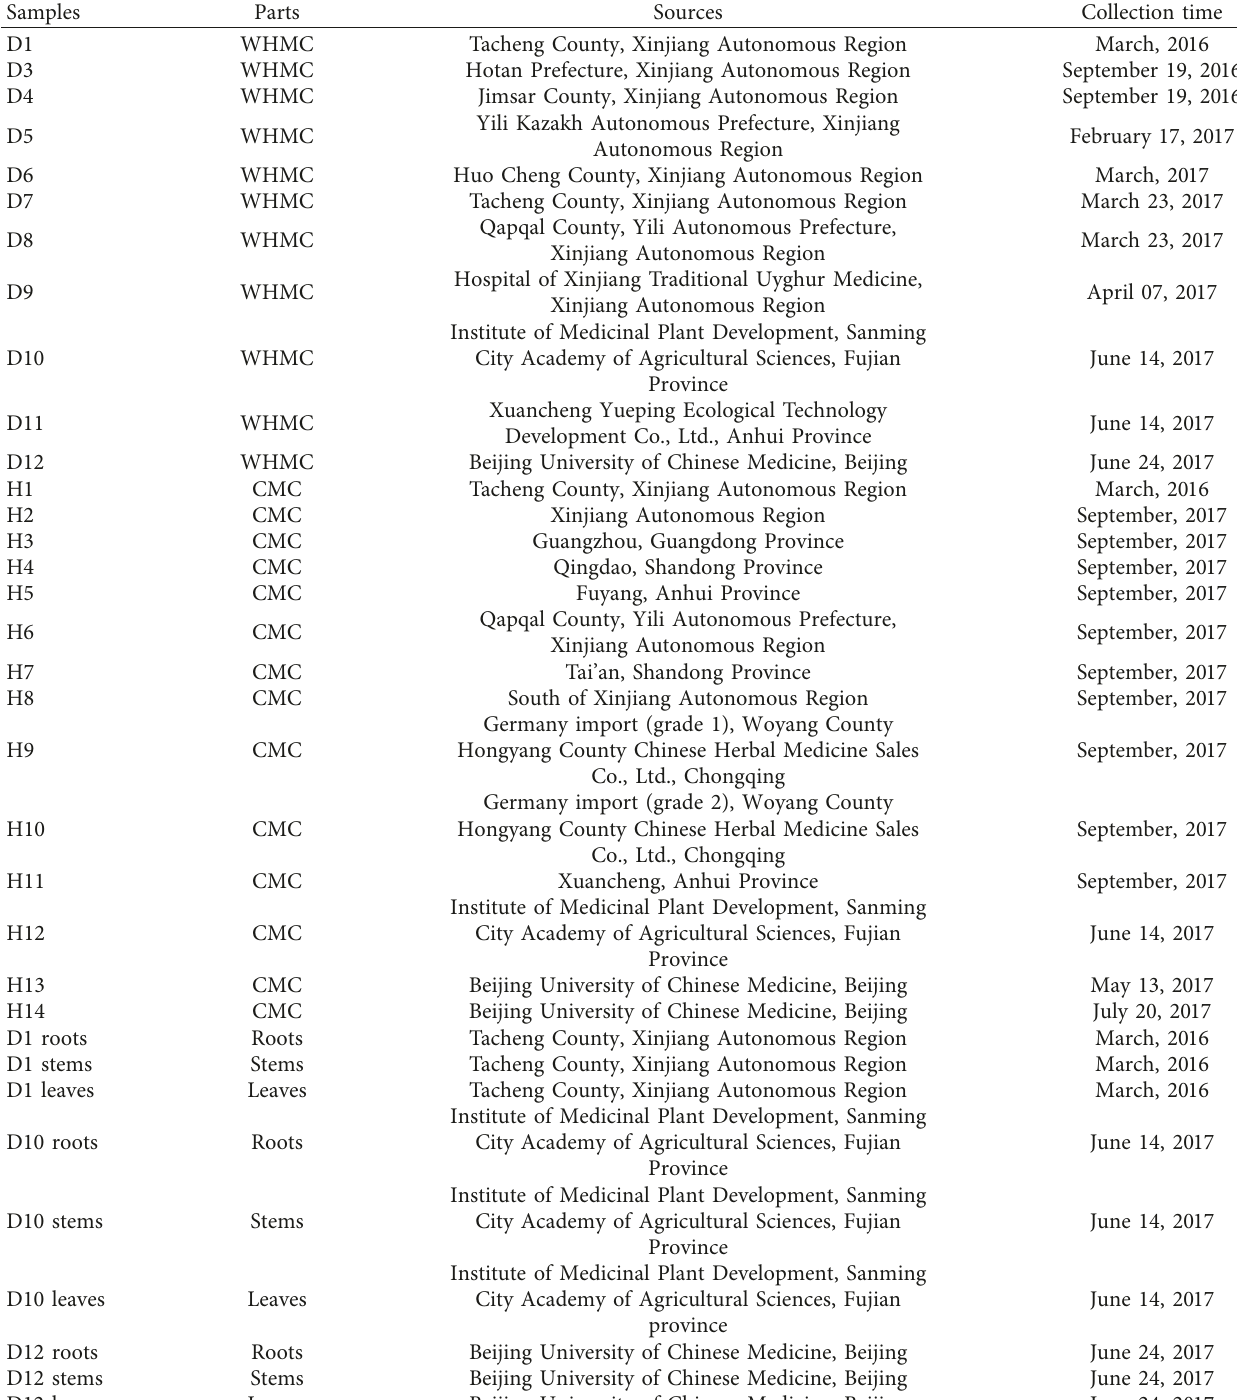
Table 1: Sample information of M. chamomilla collected from different geographical areas.